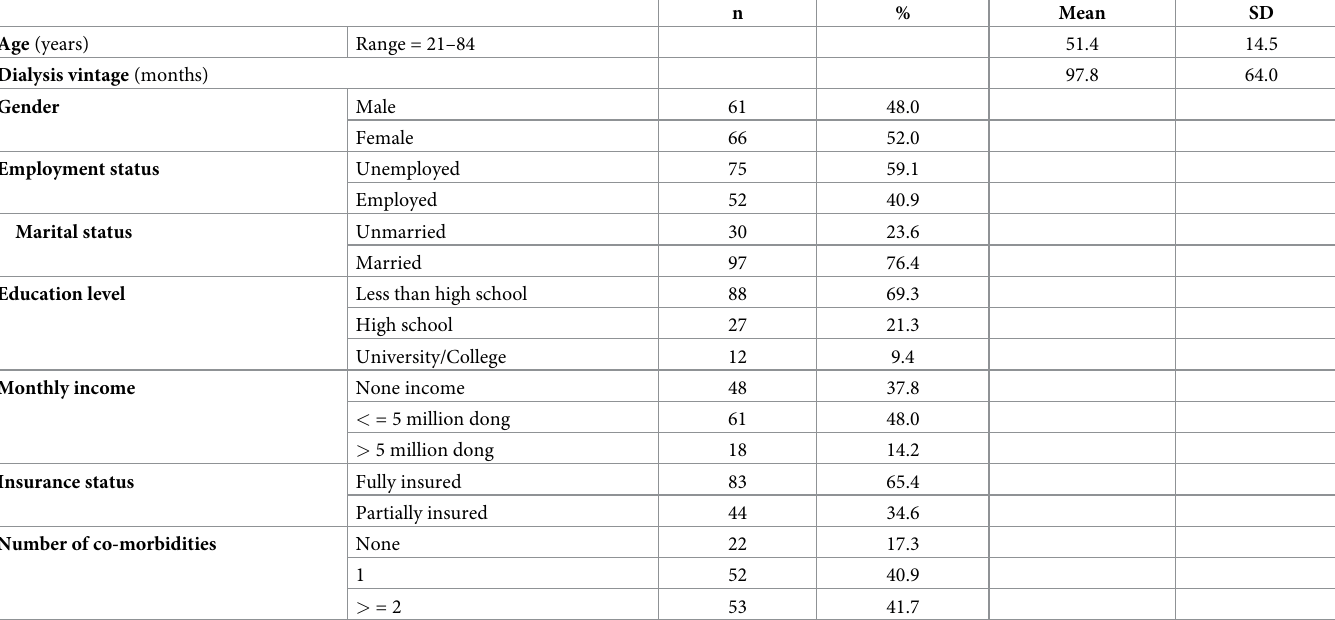
Table 1. Demographic and medical characteristics ( n =